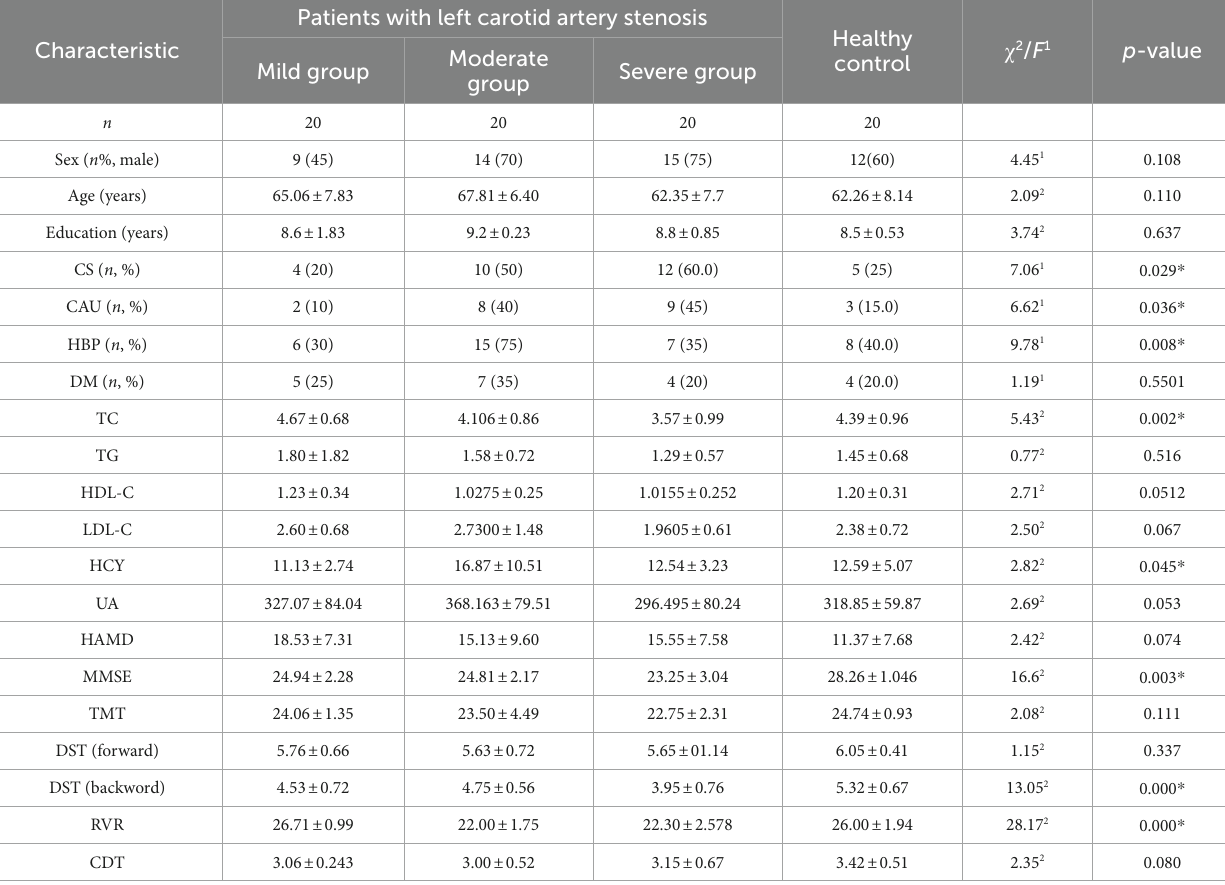
TABLE 1 Differences of clinical risk factors and neuropsychological examinations of patients with left carotid artery stenosis.